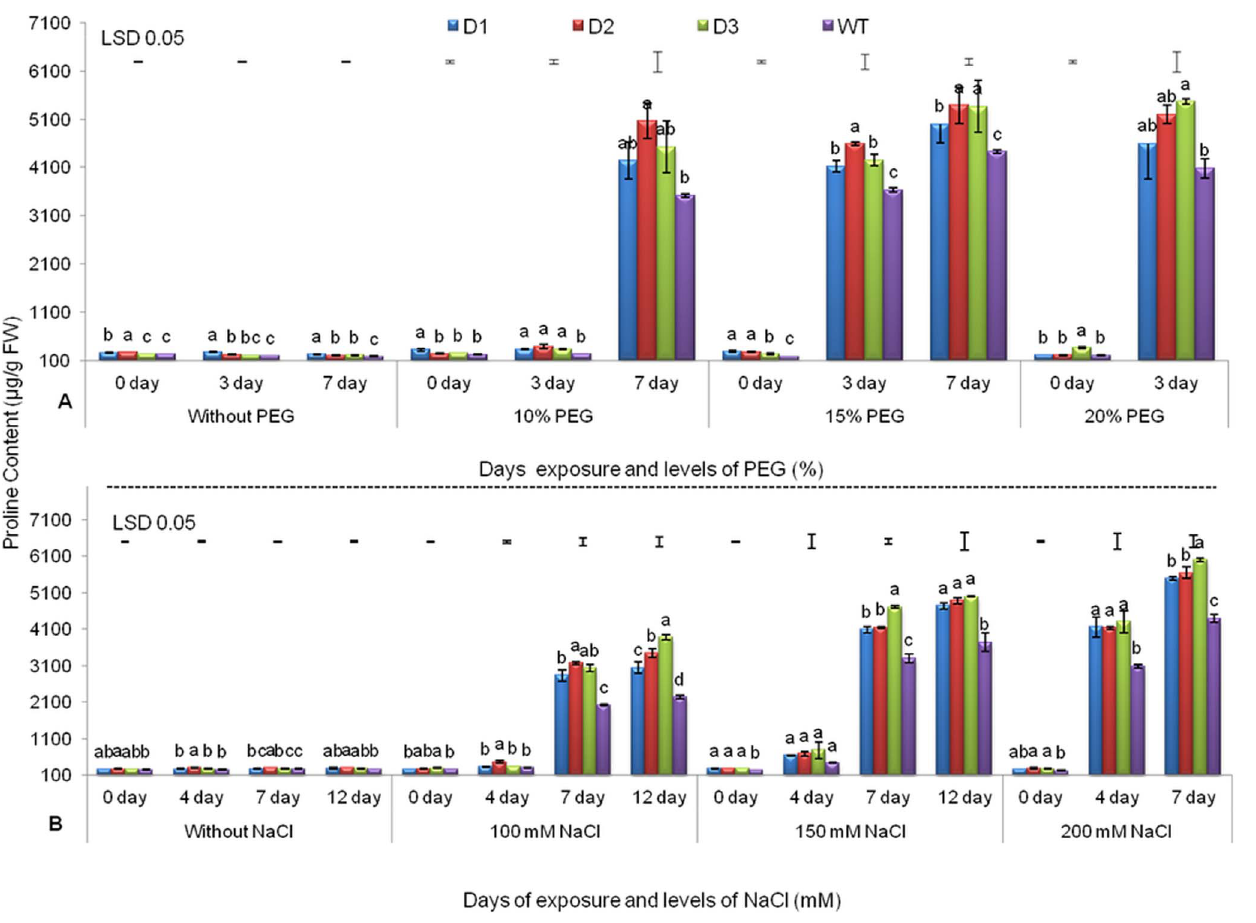
Fig. 1. Proline Content of three transgenic lines and WT. Under various levels of PEG (A) and NaCl (B) with increasing days of stress exposure. Values represent mean activities (n 5 3) ¡ SE at P 5 0.05. Means followed by the same lower case letters within a column are not significantly